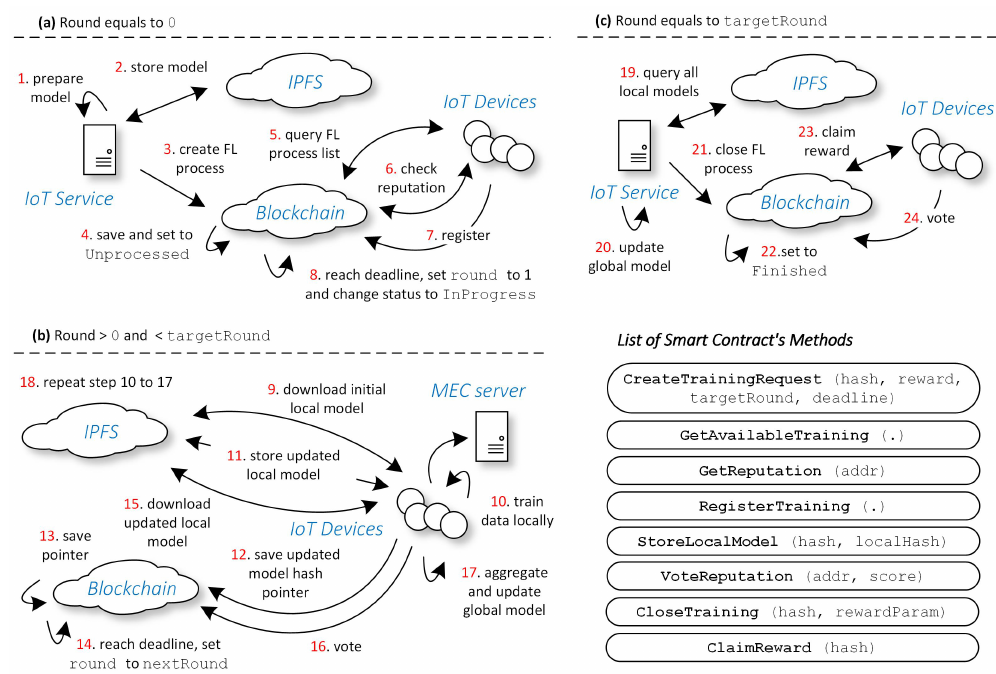
Figure 8. The overview of our blockchain design for federated learning: IoT devices first download the initial model from the IoT service. At each epoch, they train the model using private IoT data, share the result to other devices, and update the global model. Once the training is complete, the IoT service delivers rewards to IoT devices based on their contributions. We also show the list of required smart contract methods for developers to